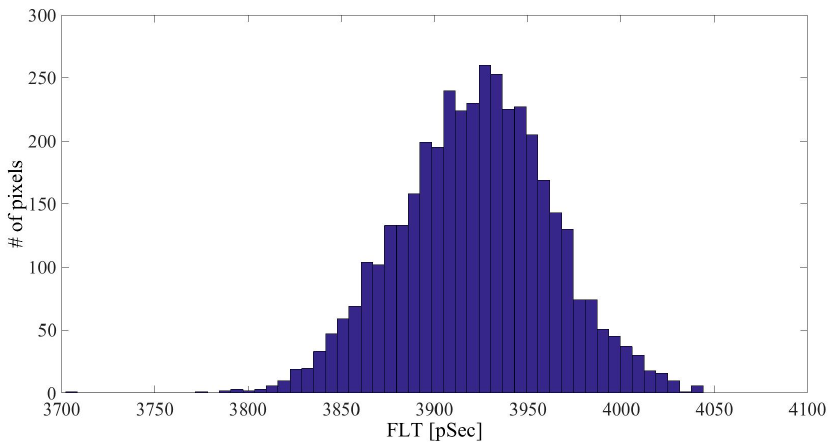
Figure 2. FLT histogram of fluorescein 0.33 µM solution.